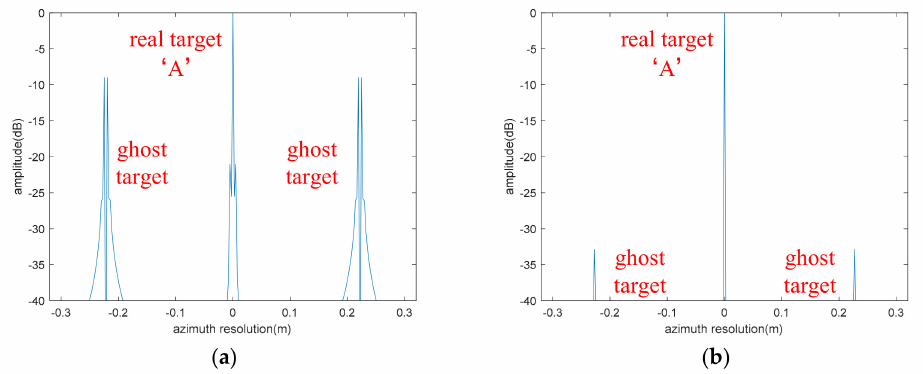
Figure 19. Azimuth profile of targets in the red dashed boxes in Figure 18. ( a ) Without compensation and ( b ) with compensation.